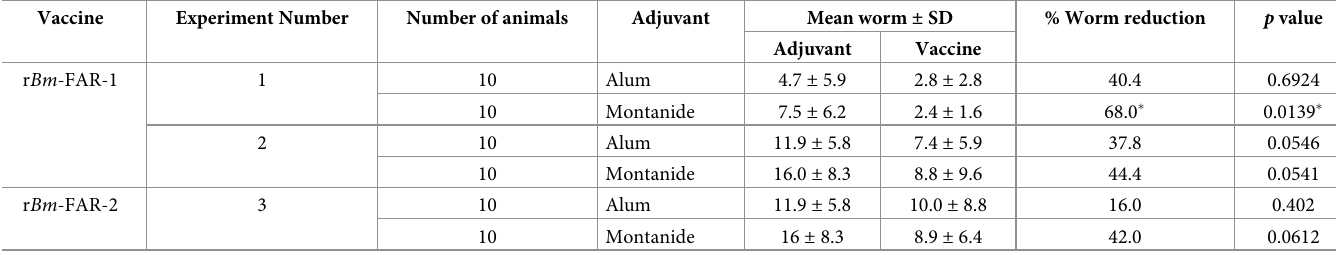
Table 1. B . malayi adult worm recovery from gerbils immunized with adjuvant-formulated r Bm -FAR-1 or r Bm -FAR-2.